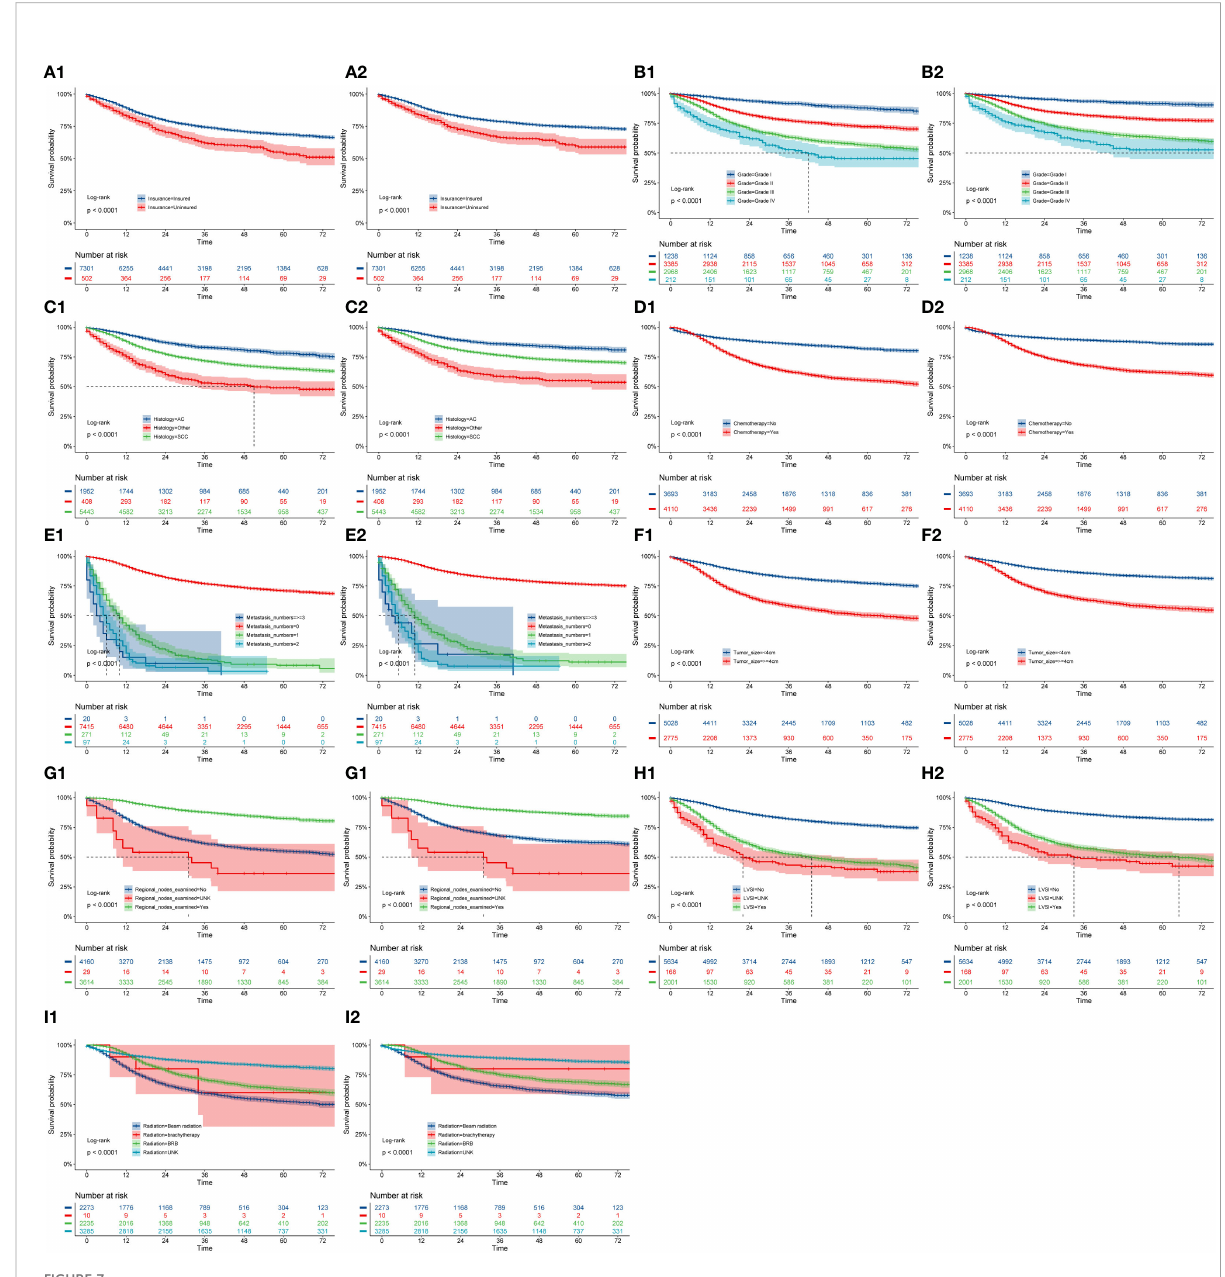
FIGURE 7 OS and CSS strati fi ed by patient characteristics in the training cohort: (A1, A2) insurance; (B1, B2) grade; (C1, C2) history; (D1, D1) chemotherapy; (E1, E2) metastasis numbers; (F1, F2) tumor size; (G1, G2) regional nodes examined; (H1, H2) LVSI; (I1, I2)